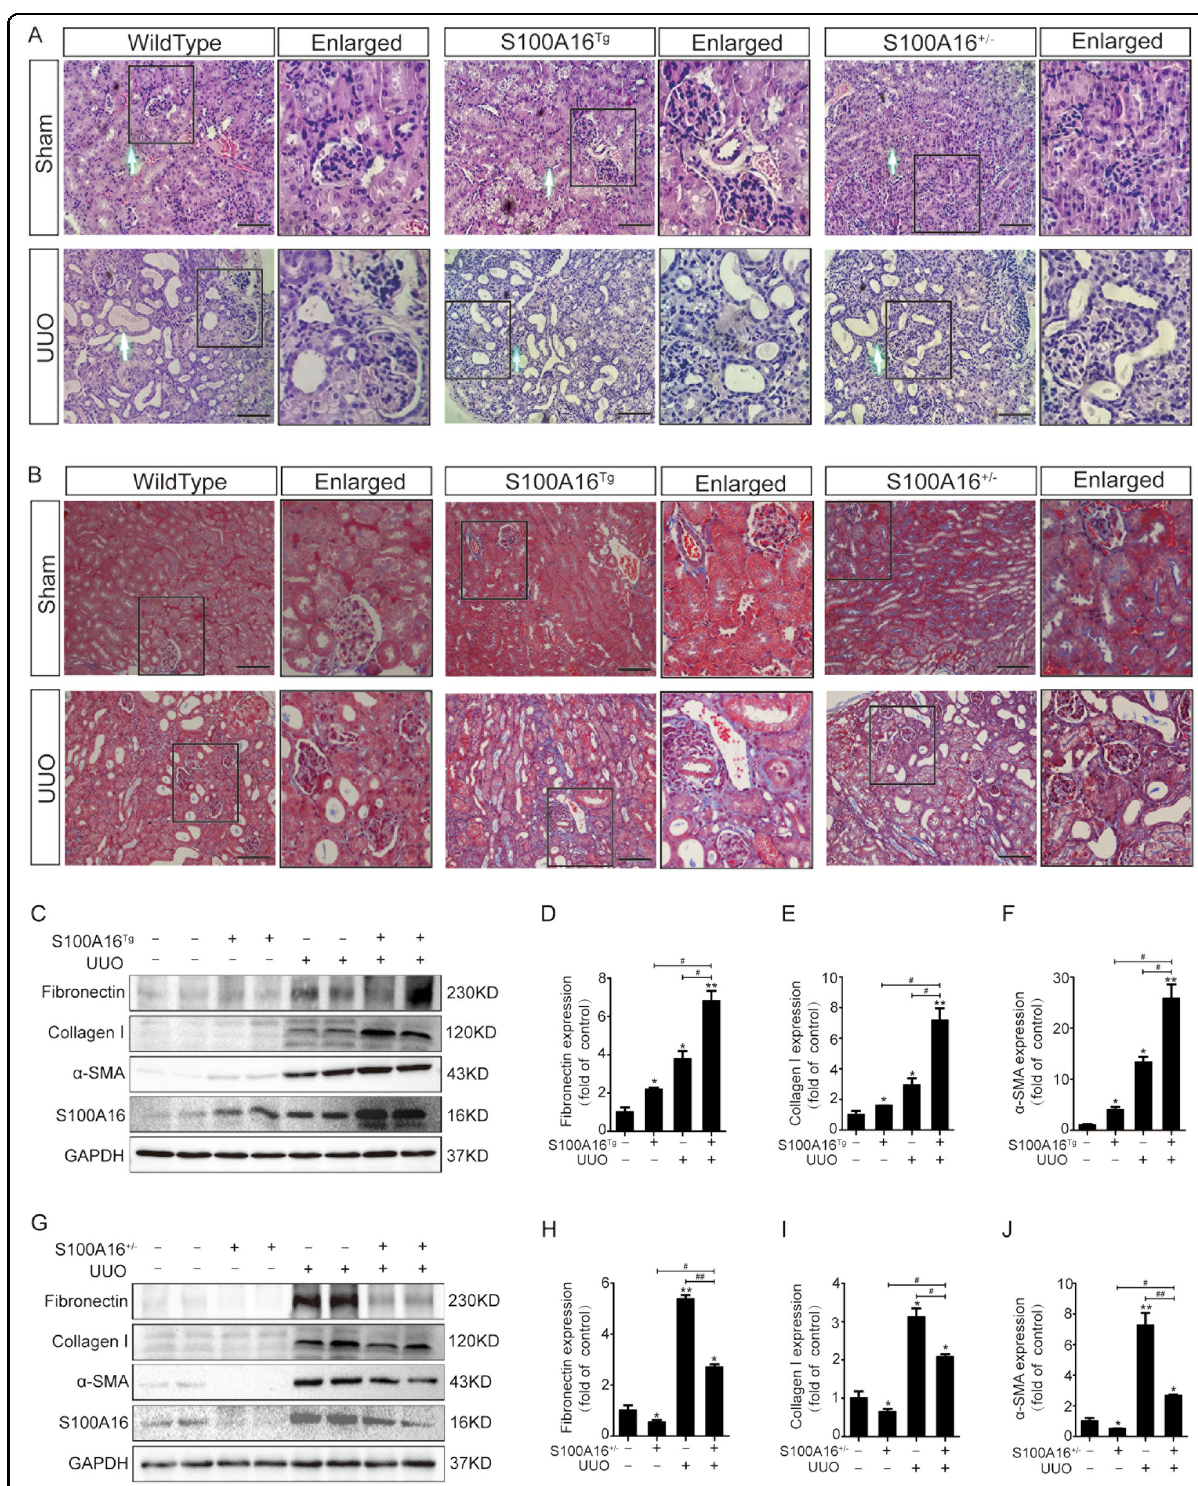
Fig. 2 S100A16 promotes renal interstitial fi brosis in UUO mice. a , b Representative micrographs of hematoxylin and eosin (HE) and Masson ’ s trichrome stained kidney tissues demonstrate renal injury in S100A16 Tg , S100A16 + / − , and wild type mouse kidneys. Scale bar = 50 μ m. c – f Representative bands (two cases) of western blots showing the expression of fi bronectin, collagen I, and α -SMA in the obstructed kidneys of wild type or S100A16 Tg mice. * p <0.05, ** p <0.01 vs. wild type sham groups; # p <0.05. g – j Representative bands (two cases) of western blots showing the expression of fi bronectin, collagen I, and α -SMA in the obstructed kidneys of wild type or S100A16 + / − mice. * p <0.05, ** p <0.01 vs. wild type sham groups; # p <0.05, ## p